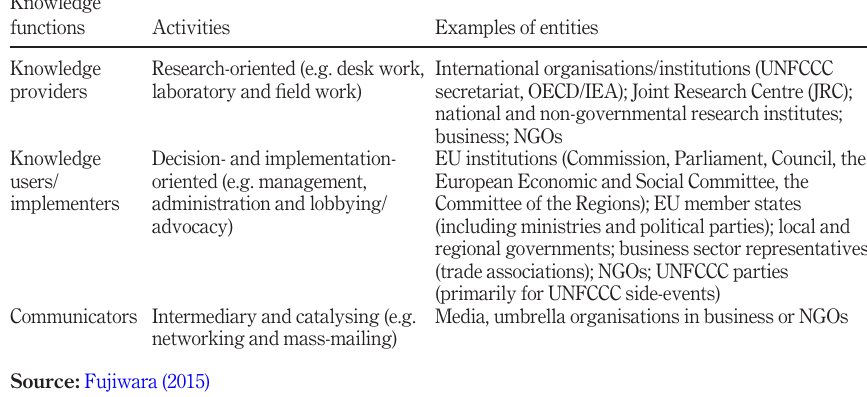
Table II. Stakeholders